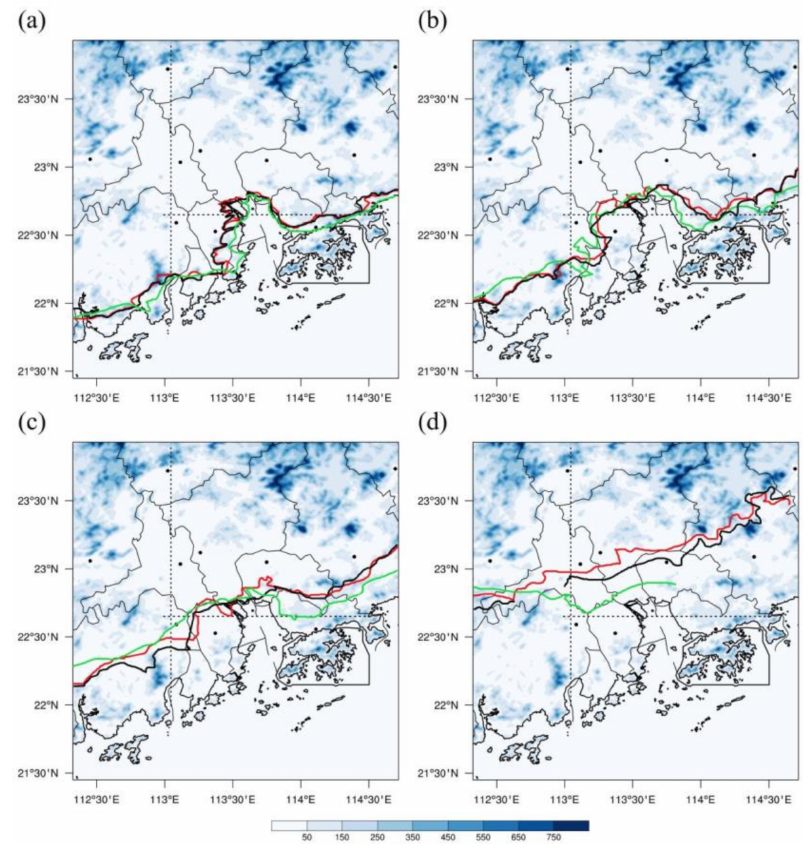
Figure 7. The locations of the sea breeze front at 1200 LST ( a ), 1600 LST ( b ), 1800 LST ( c ), 2200 LST ( d ) on 27 December 2020 for CTRL (red line), NoUrb (black line), NoTer (green line) experiments. The dotted lines are consistent with lines AB and CD in Figure